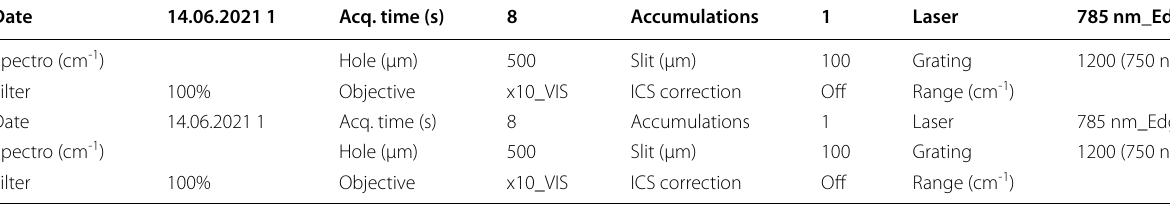
Table 2 The conditions and data for performing the Raman